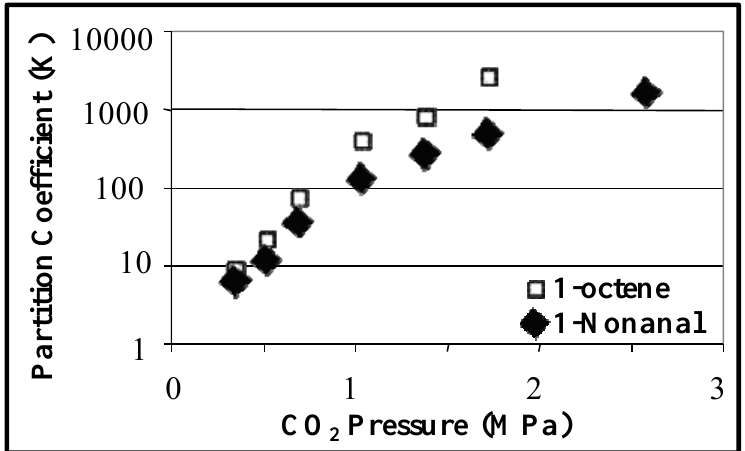
pressure in THF/H O (70:30 v:v) at 25 °C 2 2